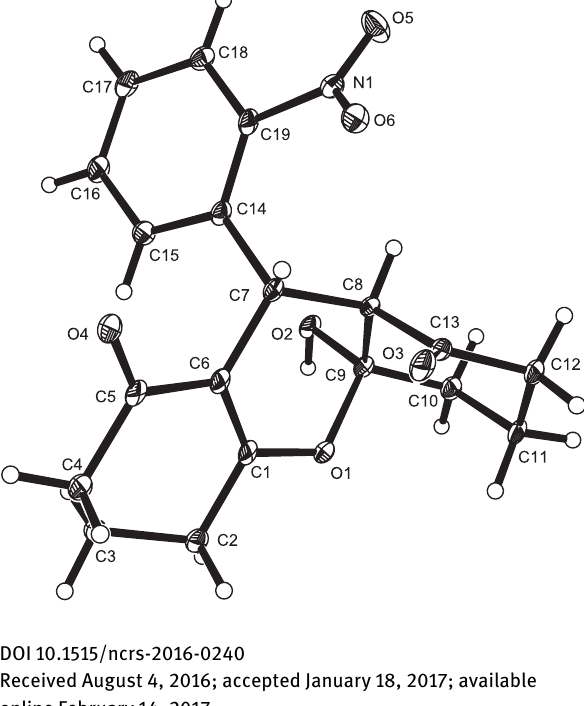
Table 1: Data collection and handling.